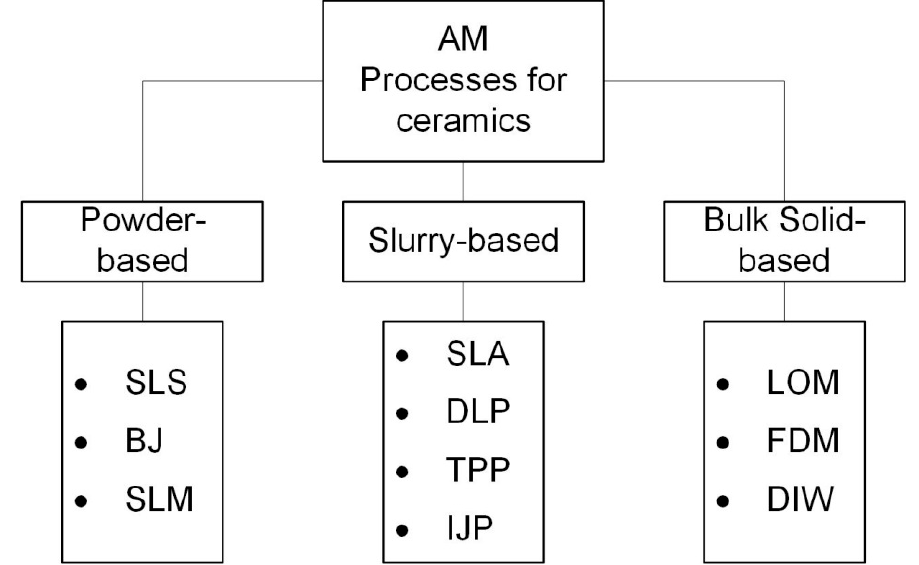
Figure 1. Classification of AM technologies for ceramics by the type of feedstock used: SLS – Selective Laser Sintering; BJ – Binder Jetting; SLM – Selective Laser Melting; SLA – Stereolithography; DLP – Digital Light Processing; TPP – Two-Photon Polymerization; IJP – Ink Jet printing; LOM – Laminated Object Manufacturing; FDM – Fused Deposition Modeling and DIW – Direct Ink Writing.